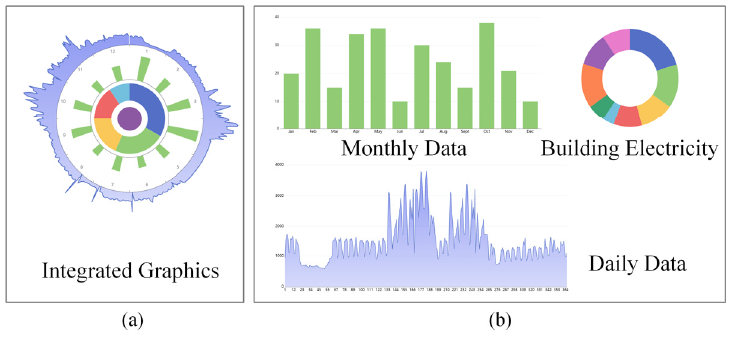
Figure 10. ( a ) Integrated visualization and ( b ) traditional visualization of electricity consumption data.